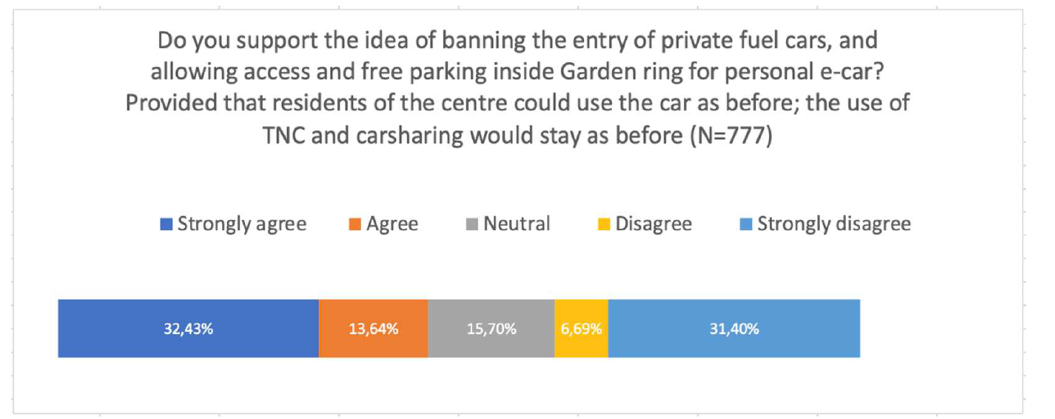
Figure 10. Future intention of respondents to banning area inside Garden Ring (city centre) for private internal combustion engine vehicles (N = 777).